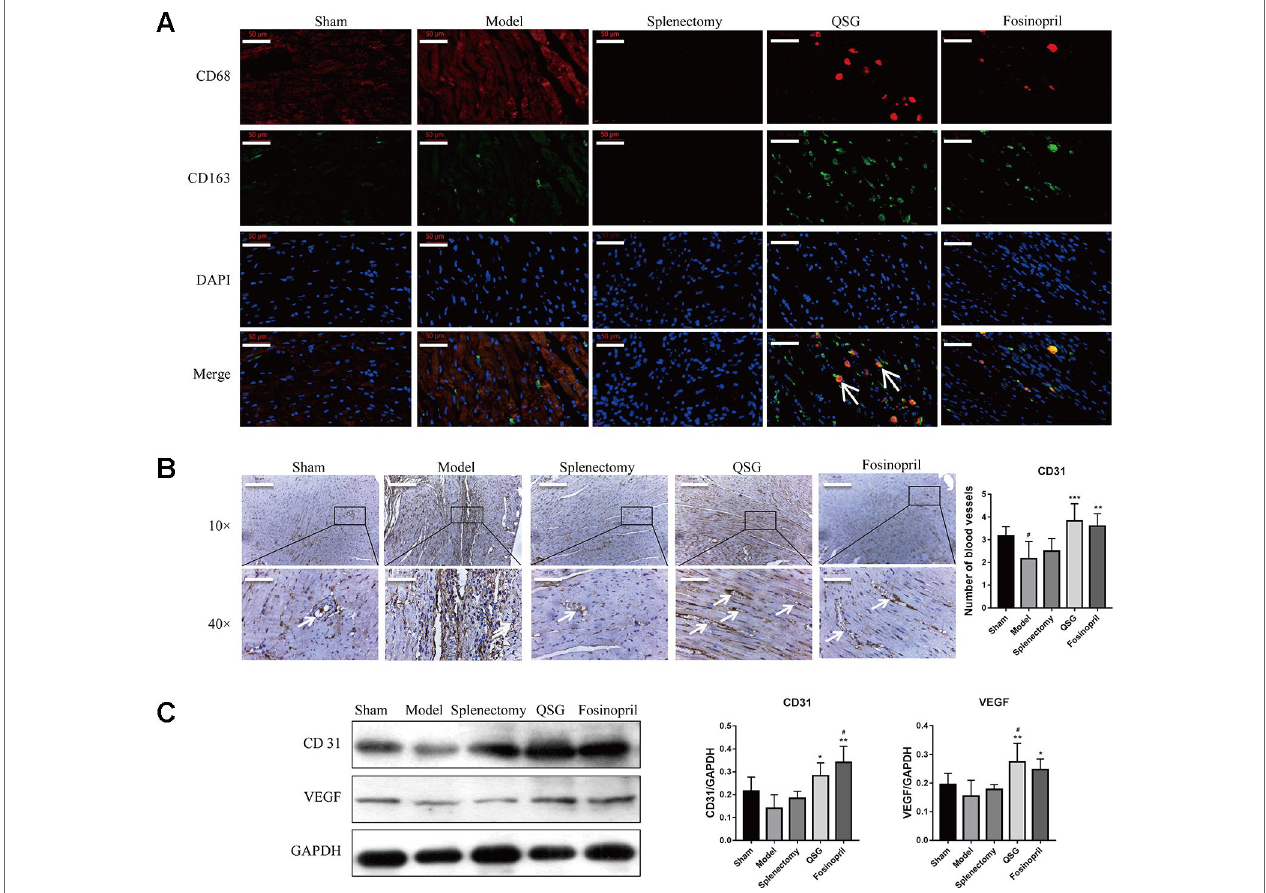
FIGURe 3 | QSG promoted angiogenesis through inducing the number of M2 macrophages in myocardial tissue. (a) IF staining showed that QSG treatment up-regulated the M2 macrophages. After splenectomy, the number of M2 macrophages remained unchanged relative to the model group. (B) CD31 staining showed that QSG could promote angiogenesis. (C) Western blot showed that QSG increased the expressions of CD31 and VEGF in myocardial tissue compared with model group. All data were presented as means ± SD from independent experiments performed in triplicate. # P < 0.05 vs the sham group; * P < 0.05, ** P < 0.01, *** P < 0.001 vs the model group. N = 3 per